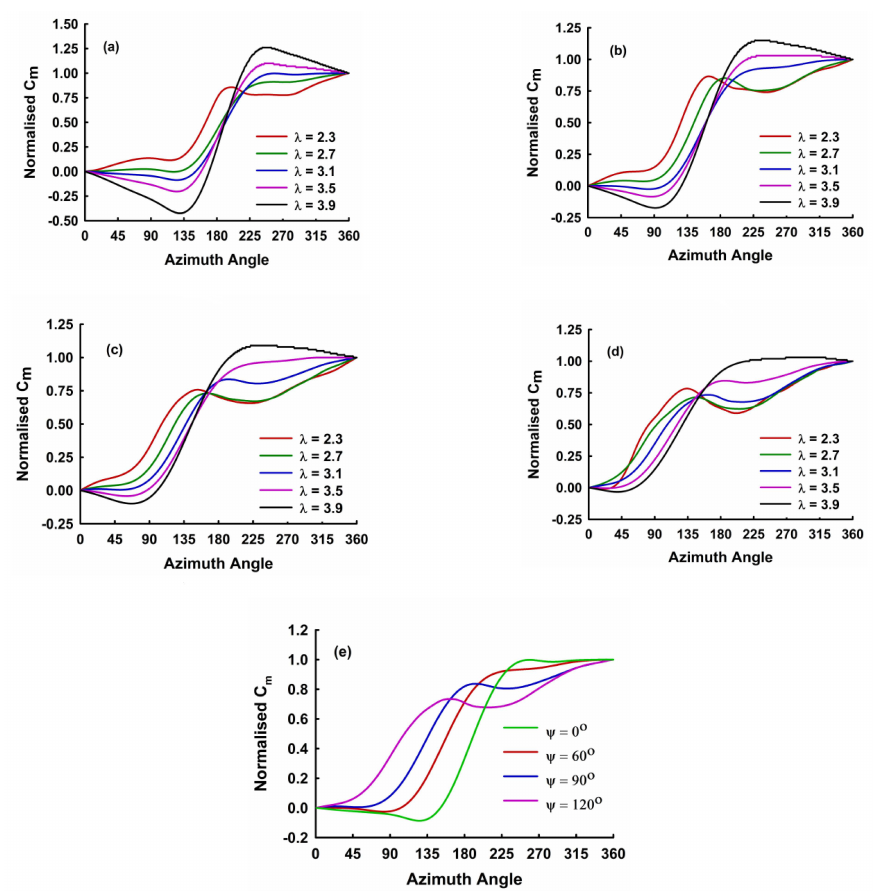
Figure 10. Normalised cumulative C m Curve of blade 1 at different λ for ( a ) ψ = 0 ◦ , ( b ) ψ = 60 ◦ ( c ) ψ = 90 ◦ , ( d ) ψ = 120 ◦ , ( e ) Normalised curve of all helical-bladed turbines compared against straight blade turbine at a TSR of 3.1.